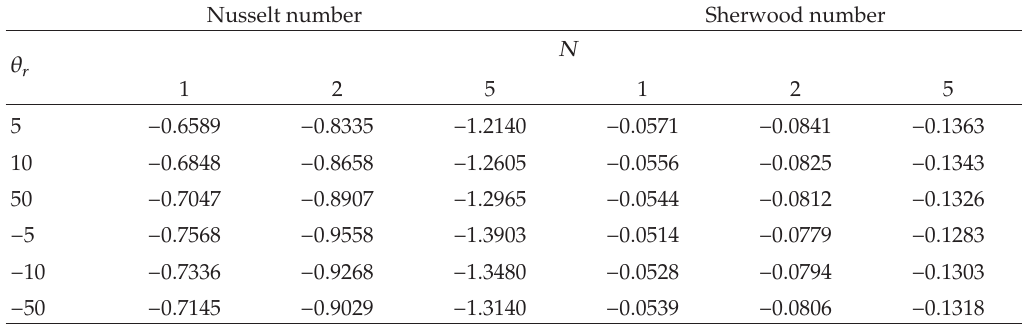
Table 1: Numerical values of Nusselt and Sherwood numbers for various values of N and θ r for Le (cid:8) 0 . 1, Du (cid:8) 0 . 03, Sr (cid:8) 2, N (cid:8) 1, and Sc (cid:8) 0 . 1. Nusselt number Sherwood